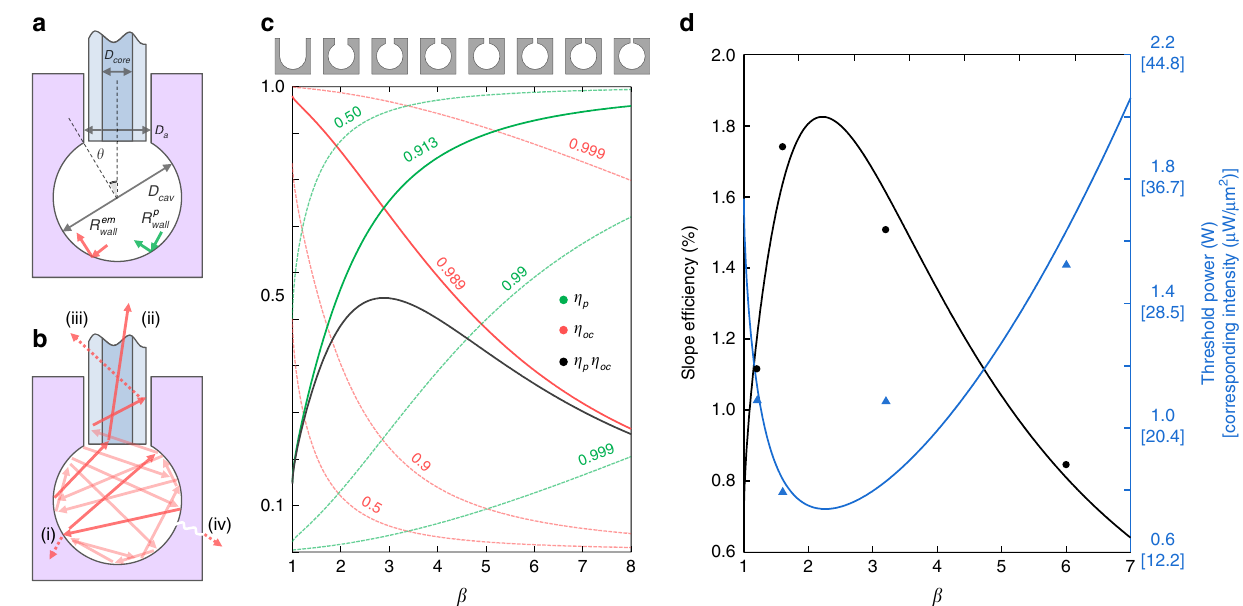
and R em are the wall re fl ectances for the pumping and emission light, respectively; Fig. 6 Theoretical model. a Schematic of the theoretical model. R p wall wall D D D fi bre core, respectively; and θ ¼ sin (cid:2) 1 ð 1 = β Þ . b Four different origins of loss: cav , a , and core are the diameters of the scattering cavity, aperture, and (i) wall re fl ection, (ii) laser outcoupling, (iii) loss through the aperture, and (iv) undesired leaks. c Variations in η p (green lines) and η oc (red lines) with different β as functions of R p (green numbers) and R em (red numbers), respectively. The schematics of cavities with different β are provided above the wall wall graph. η p η oc (black line) is shown for the experimental values of R p and R em (solid lines). It is noteworthy that the effects of fi bre and unwanted leaks wall wall have been neglected here, i.e., p noc = p leak = R oc = 0. d Experimental slope ef fi ciency (left) and threshold (right) fi tted by the theory, using p leak = 0.009, R = 0.22, and η = 0.313. The threshold intensity is shown as well for calculation of thresholds for cavities with different noc 0